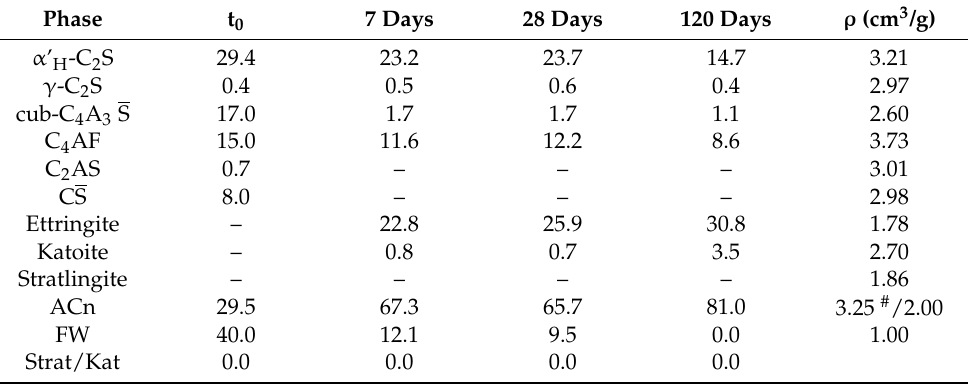
Table 6. RQPA, including ACn and FW of B-BYF with w/c = 0.40 and 0.4 wt % of SP (B-BYF- wc040_04SP), per 100 g of anhydrous cement. Density of all phases and stratlingite/katoite ratio are also included.